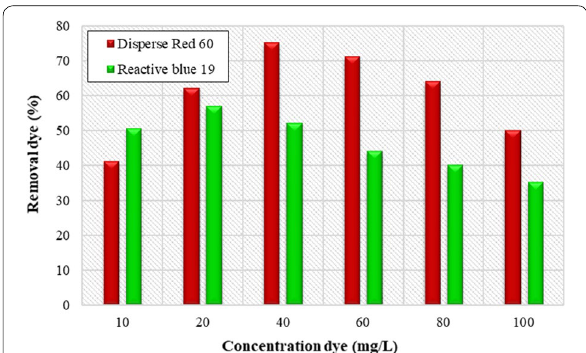
Fig. 4 Effect of initial dye concentrations on removal efficiency of Disperse red 60 and Reactive blue 19 dyes. (Initial pH rosea concentration 200 mg/L for Disperse experiments; initial = pH 11 and concentration 250 mg/L for Reactive = =